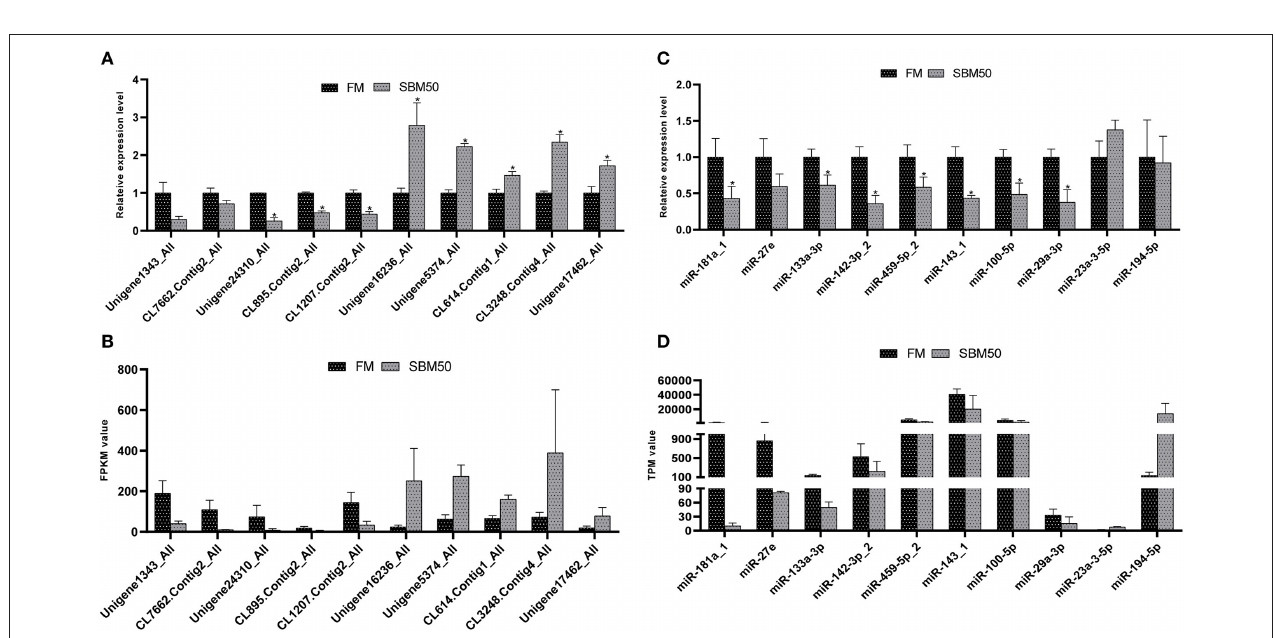
FIGURE 8 | RT-qPCR validation of differentially expressed miRNAs (DEmiRNAs), and genes (DEGs) in the FM and SBM50 groups. (A) The relative expression levels of mRNA between the two groups. (B) The value of fragments per kilobase of transcript sequence per million base pairs sequenced (FPKM) of the DEGs between the two groups. (C) The relative expression levels of the DEmiRNAs between the two groups. (D) The transcripts per million (TPM) values of miRNA between the two groups. The results of (A,C) are presented as the mean ± S.E.M ( n = 3). The sequencing results of (B,D) are presented as the mean. * P < 0.05 between two groups.